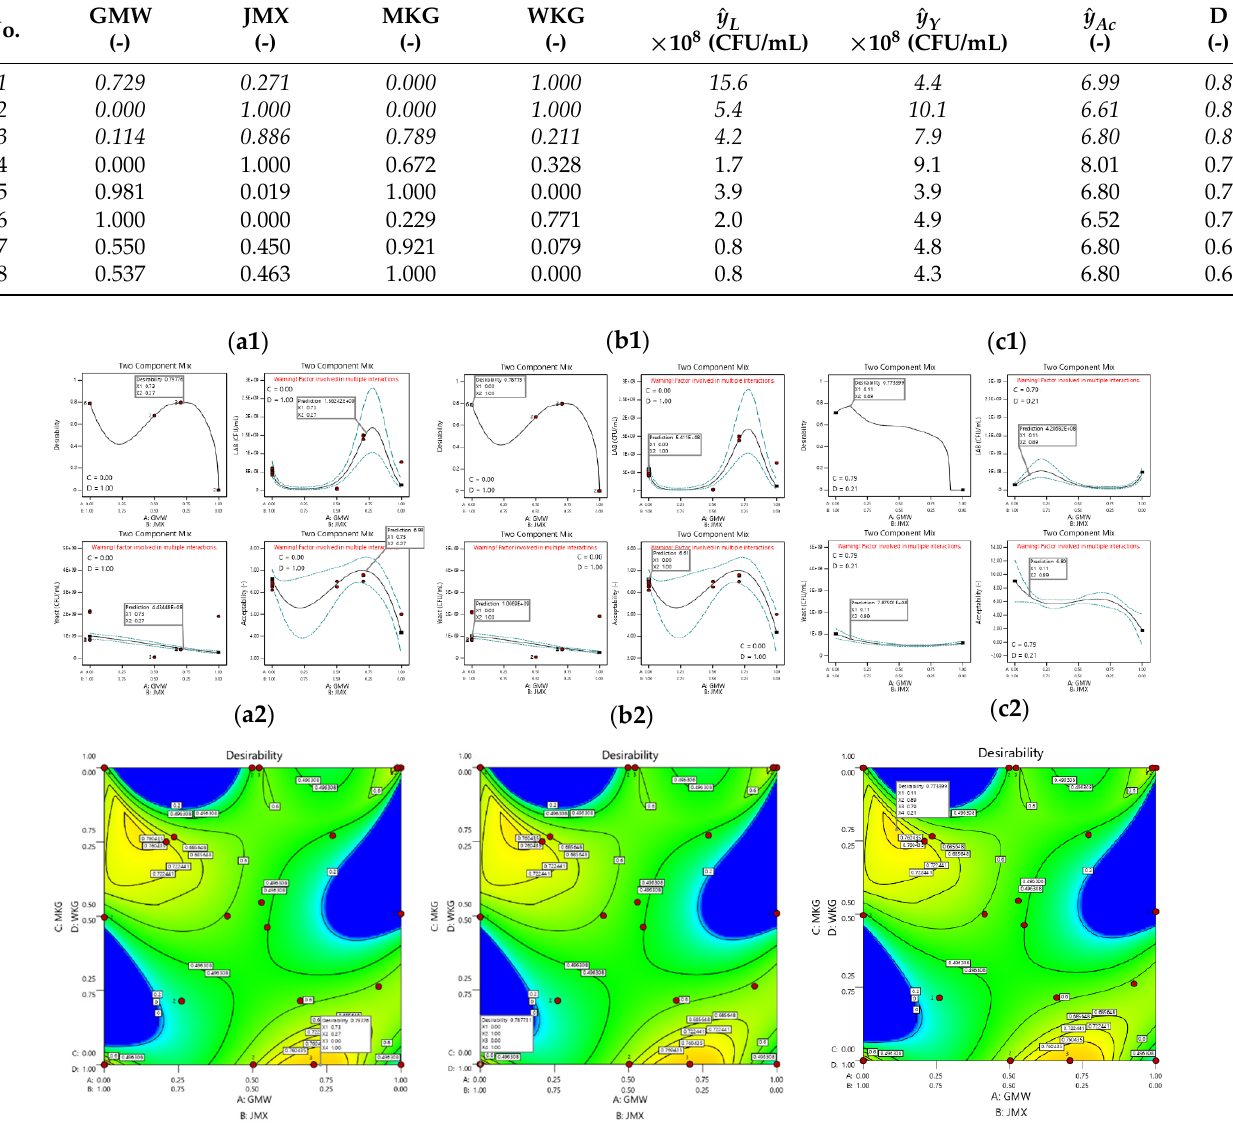
Table 3. Conditions of factors A-D, in mixtures 1 and 2, for which the suggested optimal values are obtained, by simultaneously maximizing the individual responses, with average and equal levels of relative importance between them.